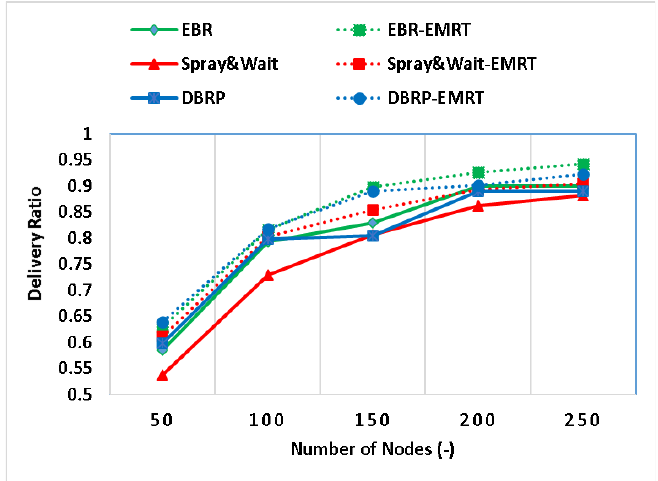
Figure 2. The delivery ratio with different node densities.